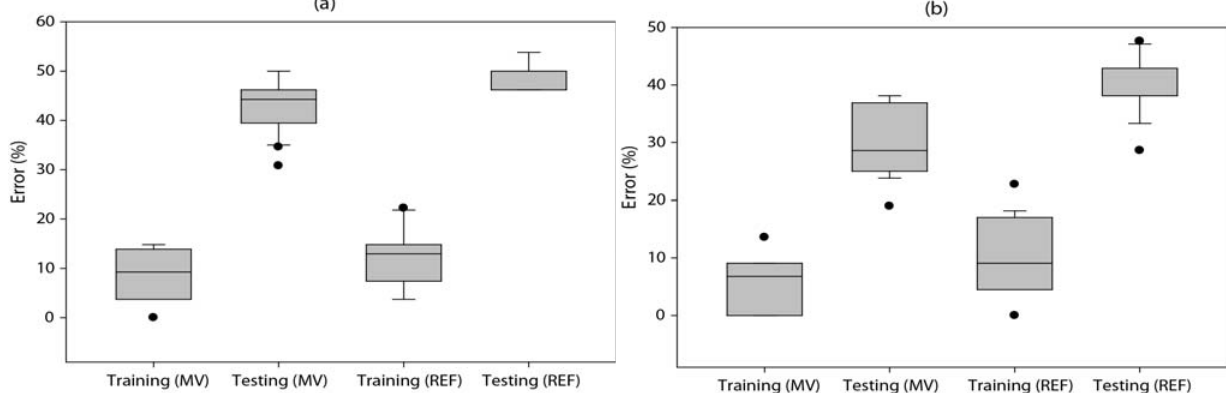
Figure 9. Box plots showing the performance variation of the multiple decision trees using different sets of training and testing samples: ( a ) for the Monticello Site, and ( b ) for the Monument Valley Site. MV represents the decision trees using the MTMF-derived metrics and vegetation indices and REF represents the decision trees using the original scaled reflectance